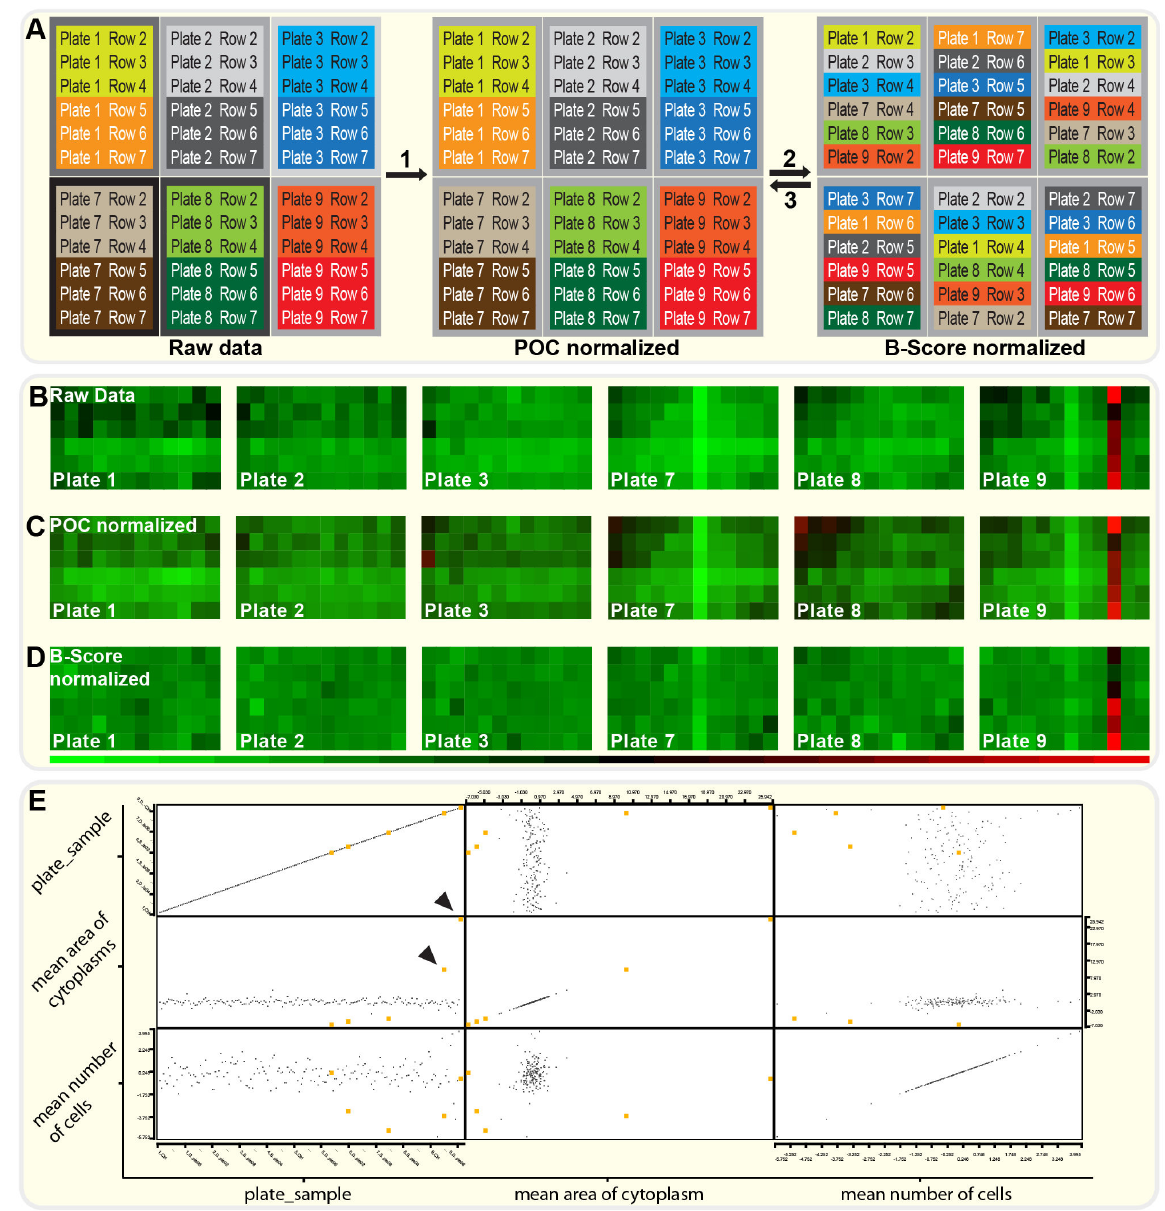
Figure 4. Data normalization and hit selection. A data analysis pipeline was developed using the KNIME software package. The steps of data normalization and hit selection are shown: ( A ) Data normalization using virtual row shuffling . A schematic representation of the data normalization procedure is shown for the three lower and upper plates of each experimental stack (9 plates total). First, a percentage of control (POC) normalization is used to normalize each plate to its corresponding DSMO control on ctrl substrate (1). Next, a virtual row shuffling algorithm is applied to allow for median averaging (B-Scoring): Hereby, rows are virtually being “shuffled” with corresponding rows from other plates of the experiment. It is made sure, that each row`s position on a virtual plate corresponds to its position on the original plate. Furthermore, only rows from plates in comparable stack positions are being mixed to prevent stack position effects to influence normalization (2). Finally, normalized data are reverse-shuffled to their original layout and subjected to hit selection (3). ( B - D ) Representative heatmaps (cytoplasm areas, increasing from green via black to red) are shown for raw data (B), POC normalized data (C) and B-Score normalized data (D). ( E ) Hit Selection . Hits are selected manually from scatter matrices generated in KNIME. Any compound, selected as hit in either plot is being marked yellow in all plots of the scatter matrix. All hits are automatically exported into hit lists for further analysis. Black arrowheads mark positive control (ROCK inhibitor Y-27632) on ctrl (left) and Nogo-A-Δ20 substrate (right). doi: 10.1371/journal.pone.0078212.g004 PLOS ONE |